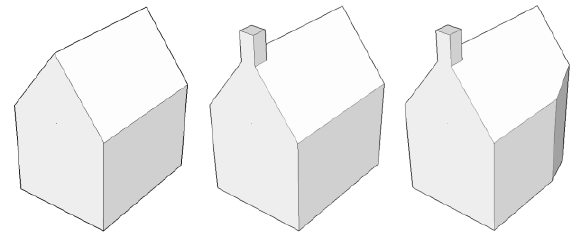
Figure 1. 3D building model with a chimney and a cropped side as two added